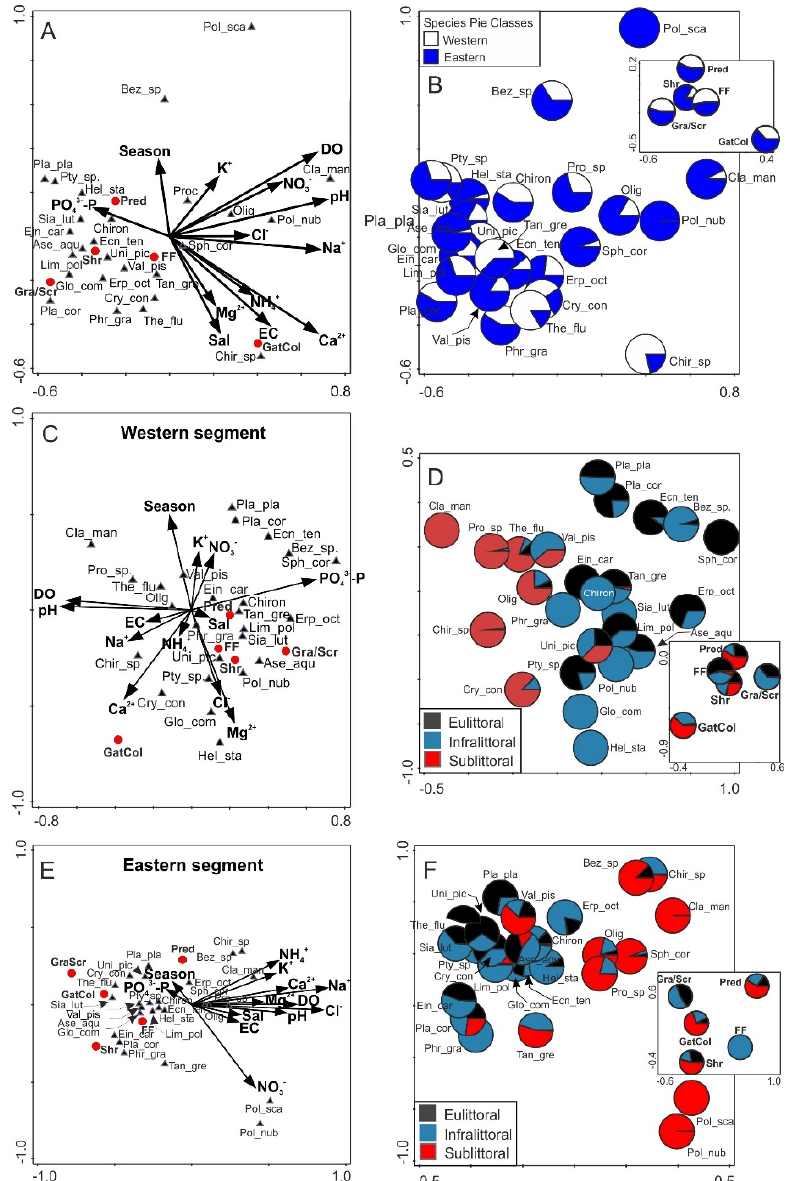
Figure 4. Results of triplot redundancy analysis (RDA) performed on percentage contributions of benthic macroinvertebrates taxa, functional feeding groups for environmental variables ( A , B ), in two segments ( C , E ) and their three depth zones ( D , F ) in the Lake Wicko ( p < 0.05). B – Relative values of macroinvertebrates taxa and functional feeding groups in pie charts in relation to segments of lake, D and F – Relative values of macroinvertebrates communities and functional feeding groups in pies charts in relation to zones in each segments of lake. Code of taxa: Olig-Oligochaeta, Hirudinea: Erp_oct- Erpobdella octoculata , Glo_com- Glossiphonia complanata , Hel_sta- Helobdella stagnalis , Crustacea: Ase_aqu- Asellus aquaticus , Megaloptera: Sia_lut- Sialis lutaria , Trichoptera: Ecn_tel- Ecnomus tenellus , Phr_gra- Phryganea grandis , Lim_pol- Limnephilus politus , Diptera: Pty_sp.- Ptychoptera sp., Chiron- Chironomidae n. det., Ein car- Einfeldia carbonaria , Cla_man- Cladotanytarsus mancus , Chir_sp.- Chironomus sp., Cry_con- Cryptochironomus conjugens , Bez_sp.- Bezzia sp., Pro- Procladius spp., Pol_nub – Polypedilum nubeculosus , Pol_sca- Polypedilum scalaeum , Tan_gre- Tanytarsus gregarius , Gastropoda: Val_pis- Valvata piscinalis , Pla_cor- Planorbarius corneus , Pla_pla- Planorbis planorbis , The_flu- Theodoxus fluviatilis , Bivalvia: Sph_cor- Sphaerium corneum , Uni_pic- Unio pictorum ; code of functional feeding groups: Gra/Scr- grazers/scrapers, FF-collector-filterers, GatCol-gatherer-collectors, Shr-shredders, Pred-predators.